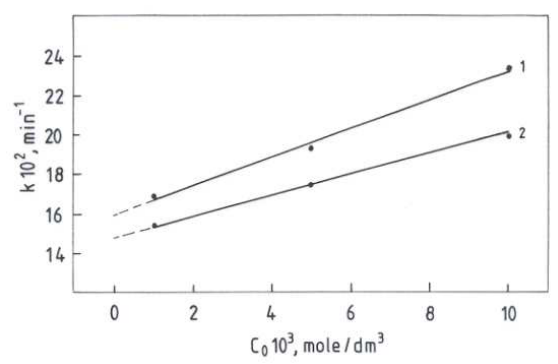
Fig. 5 The k values versus c 0 (described by Eq. (9)) for the two anesthetics, dibucaine (curve 1) and tetracaine